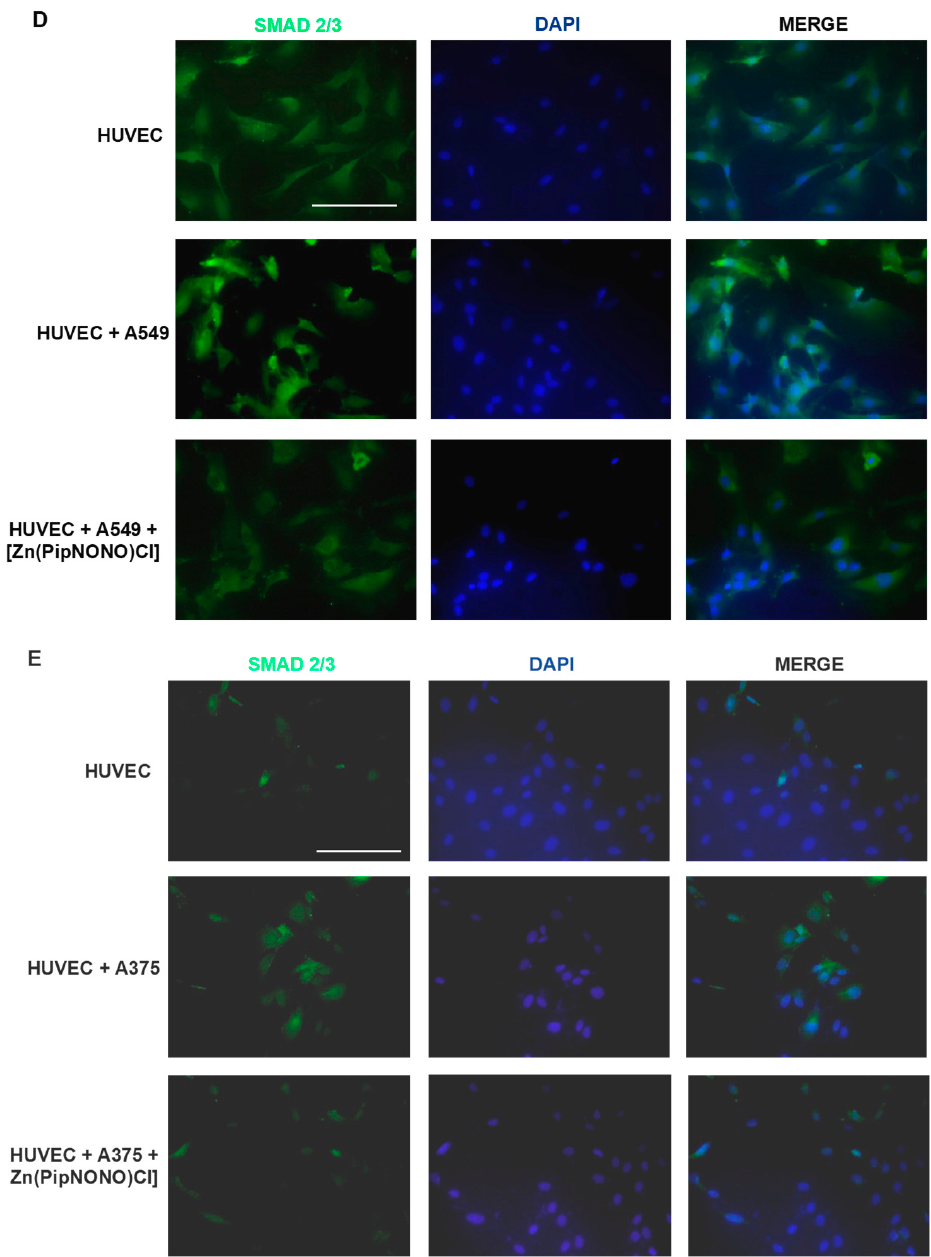
Figure 4. Effects of [Zn(PipNONO)Cl] on EndMT and TGF- β signaling induced by tumor cells co- culture. ( A ) Assessment of the endothelial cell survival following treatment with [Zn(PipNONO)Cl]. This preliminary experiment excluded any toxic effect by 10 and 50 µ M concentrations of [Zn(PipNONO)Cl] on HUVECs. ( B , C ) Expression of typical markers of endothelial and mesenchymal phenotype in endothelial cells in co-culture with A549 ( B ) and A375 ( C ). The order of loading of the samples was: HUVECs alone (Control, Ctr); HUVECs + tumor cells (cell co-culture); HUVECs + tumor cells + [Zn(PipNONO)Cl] (cell co-culture treated with 10 µ M of the metal nonoate). A representative image out of 3 with overlapping results is reported. Whole blots and densitometry readings of the bands are reported in Supplemental material Figure S2 and Table S2. ( D , E ) Images of immunostaining for Smad2/3 (green) and DAPI (blue) in HUVECs treated with 2% FBS, co-cultured with A549 ( D ) or A375 ( E ) for 4 days in the absence and in the presence of 10 µ M [Zn(PipNONO)Cl]. Images were obtained by using fluorescence microscope (Nikon Eclipse E400 at 40 × magnification). Scale bar, 50 µ